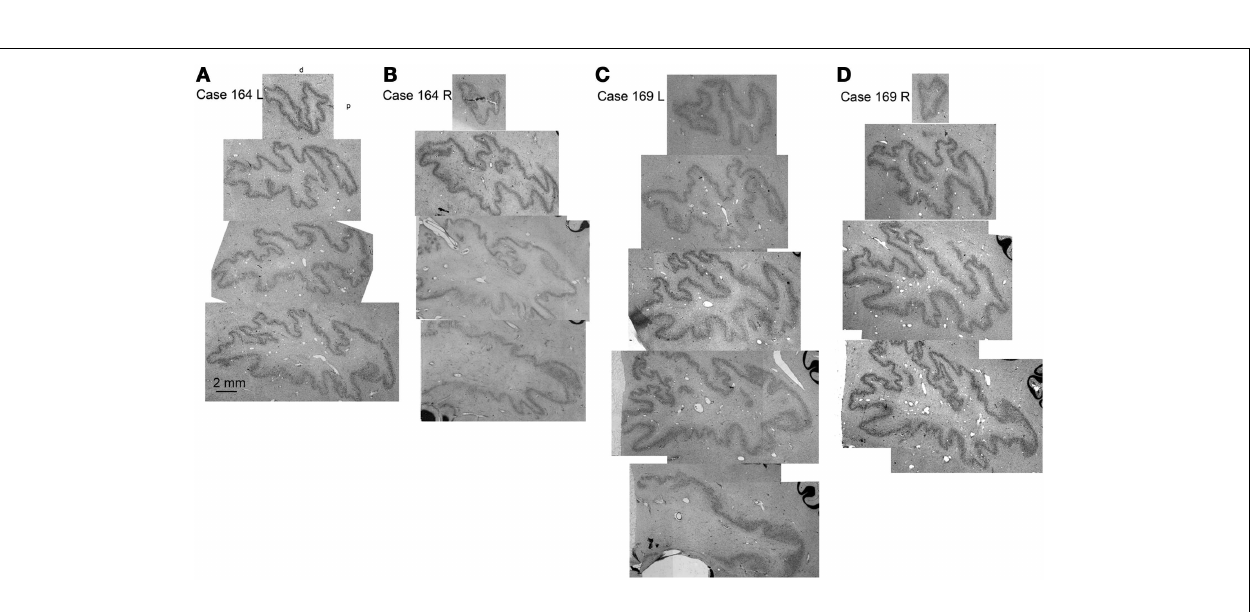
164 (female, age 45) and (C,D) show the left and right sides of Case 169 (male, age 70).The images are scans of CV-stained sections from a flat bed